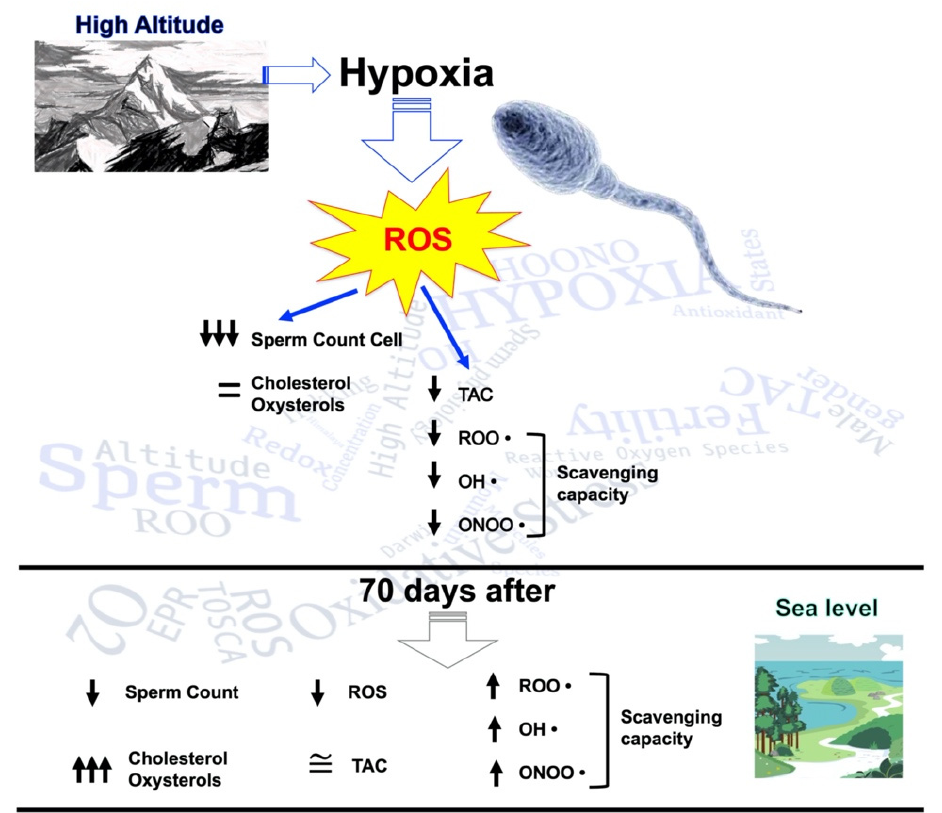
Figure 6. Scheme of the influence of high altitude on sperm count cells, cholesterol, oxysterols, reactive oxygen species (ROS) production, and antioxidant capacity. Evaluation was performed with seminal fluid collection.